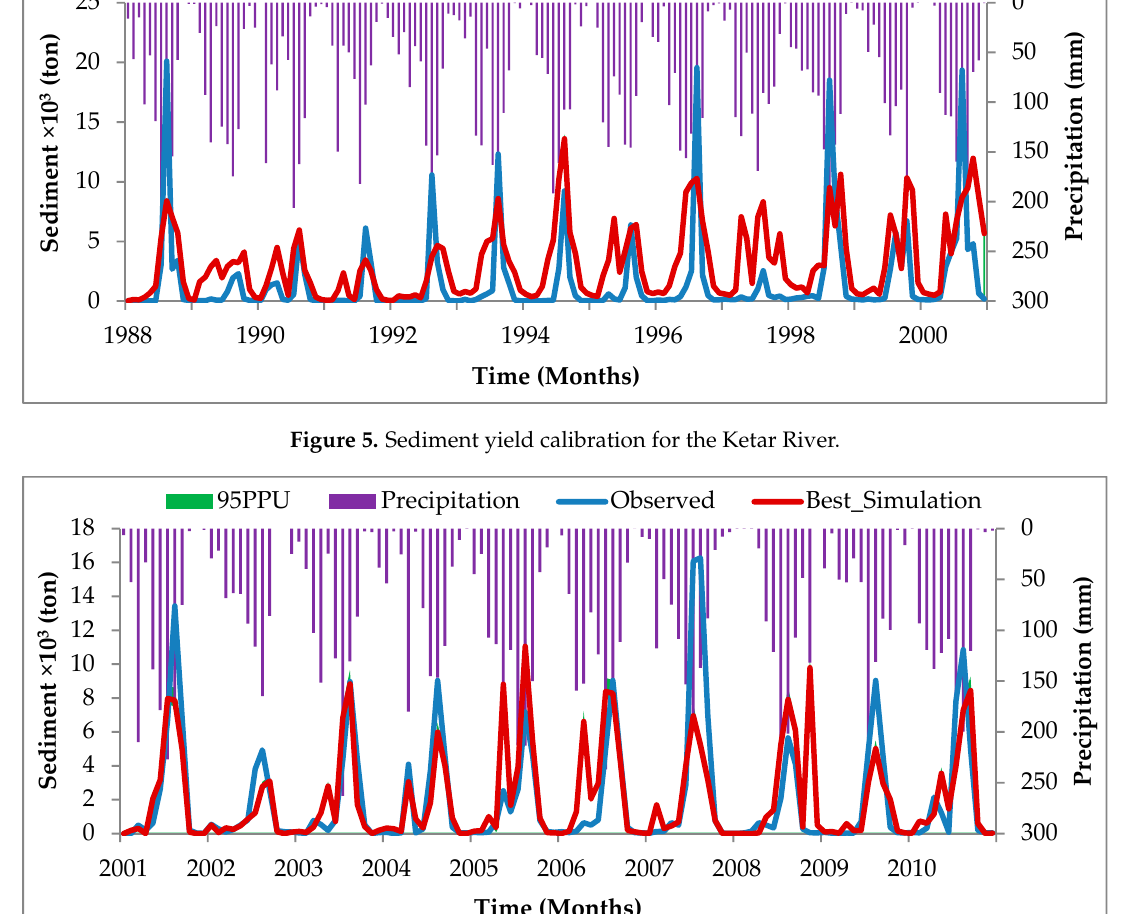
Figure 7. Sediment yield validation for the Ketar River. 3.3. Effect of Climate Change on Lake Sedimentation The average annual sediment yield contributions to Lake Ziway were 431.05 ton/km 2 and 322.82 ton/km 2 for the Meki and Ketar rivers, respectively, in the historical period (1985–2010). The average annual sediment yield showed a decreasing pattern in the future climate scenario as compared to the historical period (Table 5). The average percentage decrease in sediment yield ranged from 11.3 under RCP8.5 for the Meki River to 51.5 under RCP4.5 for the Ketar River. This might be related to a decrease in streamflow in the future scenario period (2041–2070), which in turn was related to a decrease in the precipitation amount. The projected climate data outputs from the ensemble mean of regional climate models (RCMs) in our study show that precipitation will decrease, while the minimum and maximum temperature will increase, as described in Section 3.1. The increase in temperature is further associated with an increase in evapotranspiration. Thus, the combined effects of decrease in precipitation and increase in temperature in the future period might cause a reduction in streamflow. It has also been shown that there is a significant relationship between streamflow and sediment yield with a coefficient of determination (R 2 ) of 0.9. Hence, the result implies that the reduction in sediment yield in the future period is associated with the reduction in streamflow, which is associated with different climate factors. Table 5. Sediment yield estimation. River